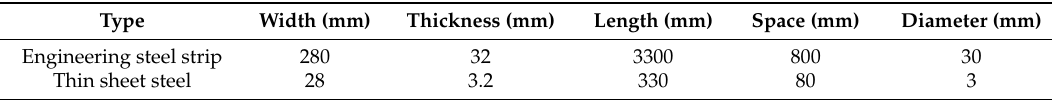
Table 4. Geometrical parameters of steel strip.